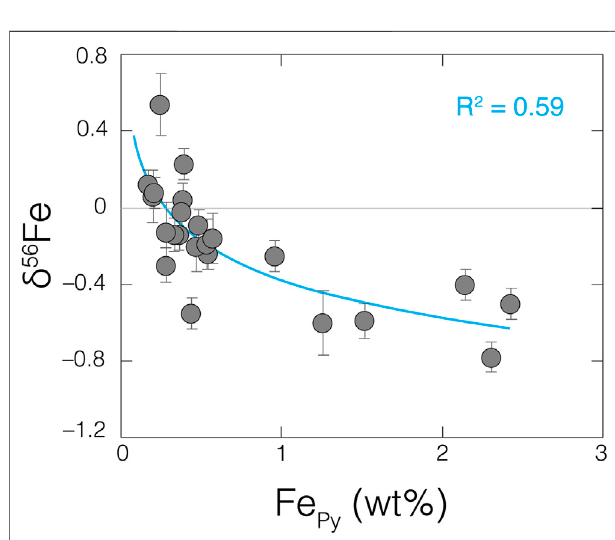
FIGURE 6 | Increasingly negative bulk-shale δ 56 Fe values are accompanied by higher pyrite Fe contents (Fe Py ) in our samples, drawing a strong connection between two. Pyrite Fe data are from Ostrander et al. (2020). A logarithmic trendline through the dataset is provided in blue, along with the corresponding R 2